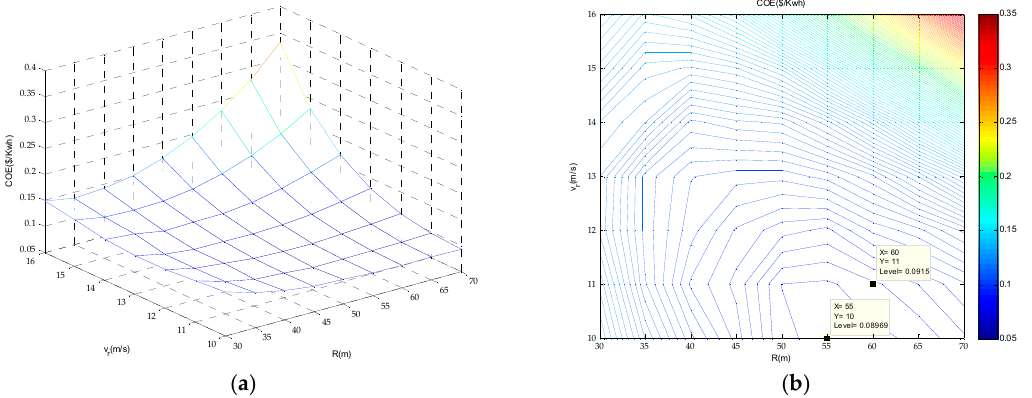
function and ( b ) optimal layout. and ( b ) optimal layout.